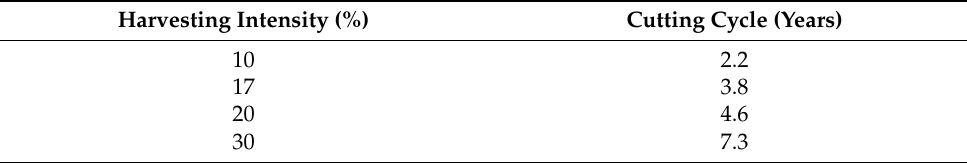
Table A2. Cutting cycle estimated considering different harvesting intensity. Calculations based on the MAI, excluding remnant trees ( ≥ 55 cm DBH).